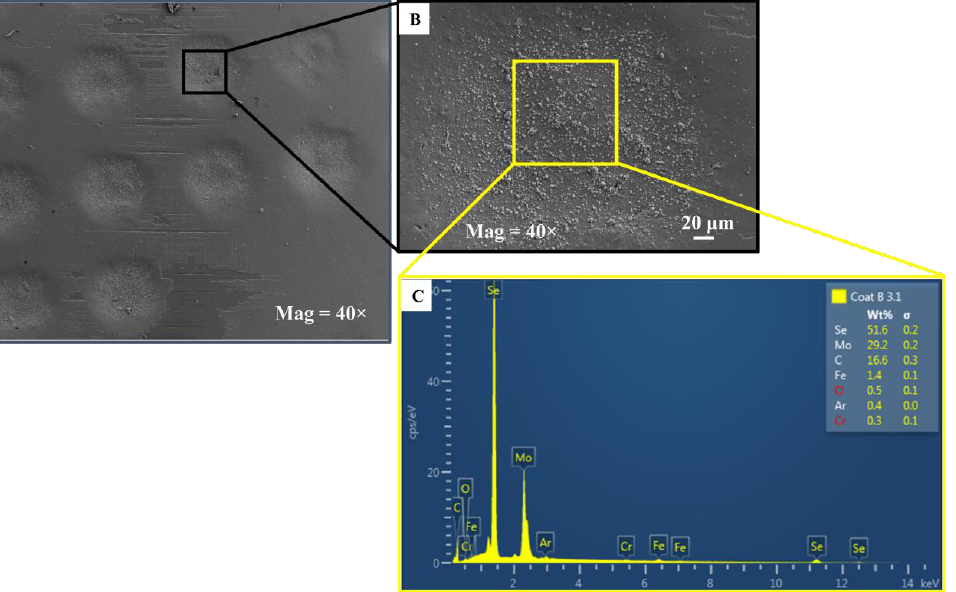
Figure 11. SEM image of ECP_S C _MoSeC specimen showing: ( A ) Image of textured surface; ( B ) Mag- nified image of dimple; ( C ) EDS data.